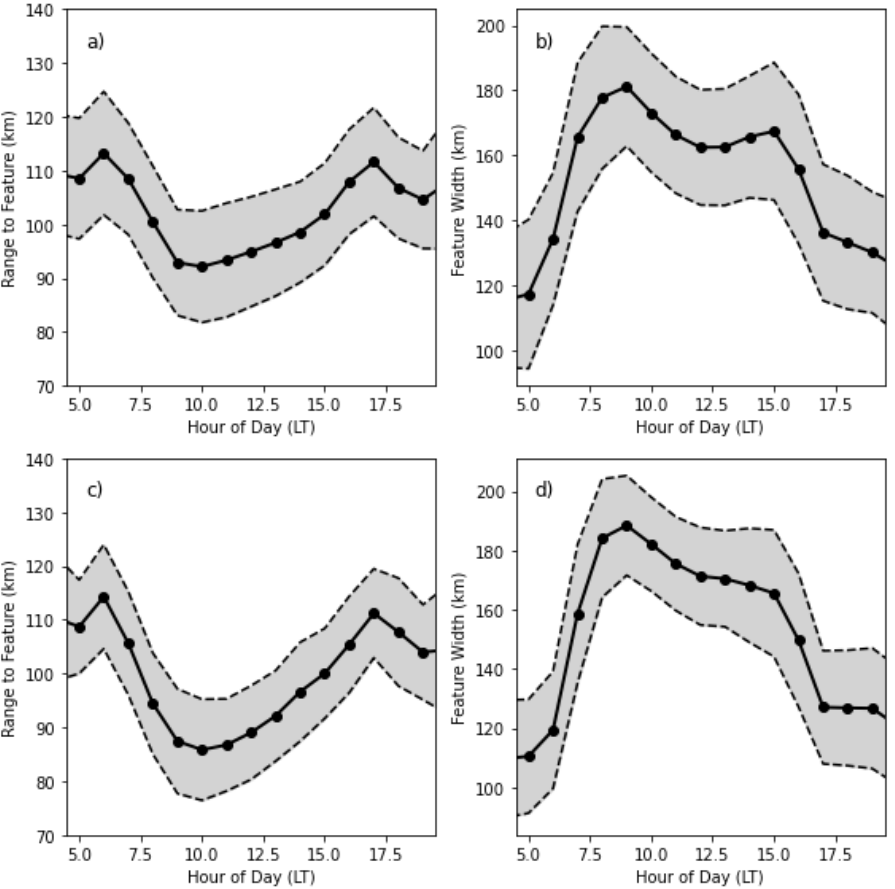
Figure 10. Diurnal variability of extracted CNF-E features as seen with hour-of-day mean spanning the entire timeseries. ( a ) Hour-of-day mean of range to feature (R f ) and ( b ) feature width (W f ) at KAYA, ( c ) R f and ( d ) W r at ANGU where mean is represented as solid black line and dots and standard deviation is represented by dashed lines and gray fill.